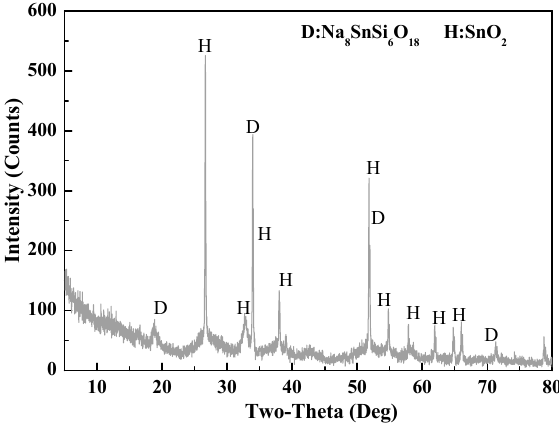
Figure 6. XRD pattern of the leach residues (Sample 2# in Figure 3).